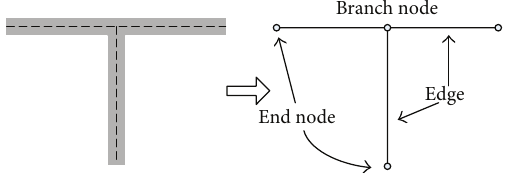
Figure 1: Concept of thinning.